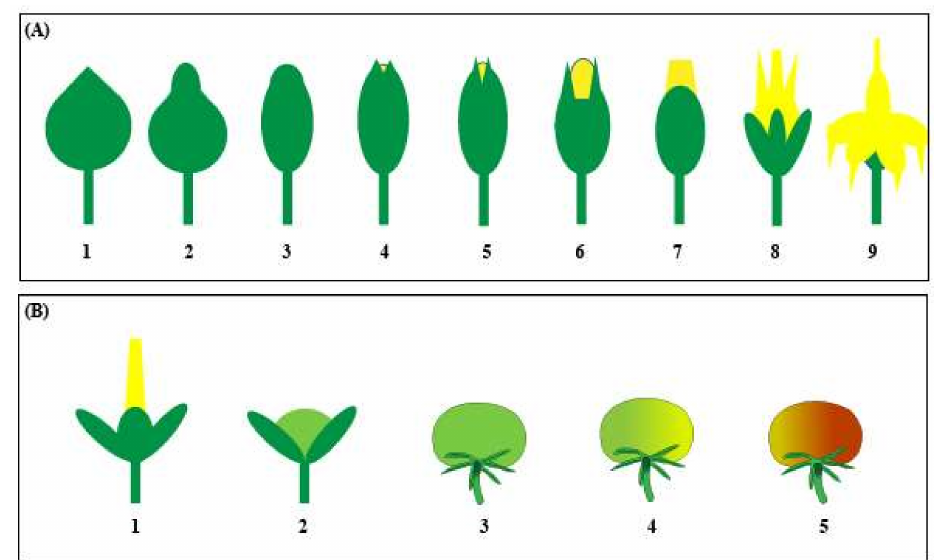
Figure 3. Stylised diagram of tomato flower and fruit development stages. ( A ) Tomato flower devel- opment. A numbered scale (1–9) is used to denote each new stage. It can take ~1–2 days/stage until the flower bud (stage 1) reaches full maturity (stage 9; ~15–17 days). ( B ) Tomato developmental stages